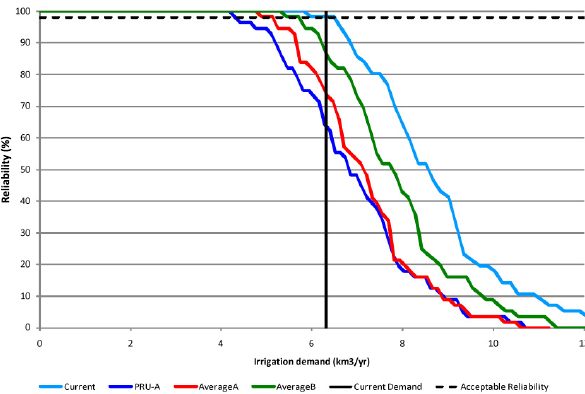
Fig. 4. Demand reliability curves for current conditions and for cli- mate projections Average B (Average for B2 scenario), Average A (average for A2 scenario) and PRU-A (average of Prudence models for A2 scenario).